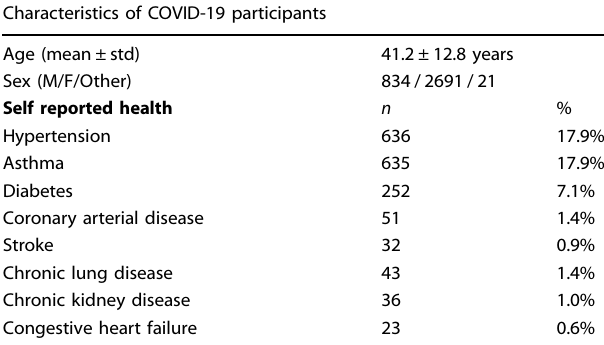
Table 3. Self-reported health characteristics of participants who reported either a positive PCR test or a positive serological test; note that some participants may have received both.